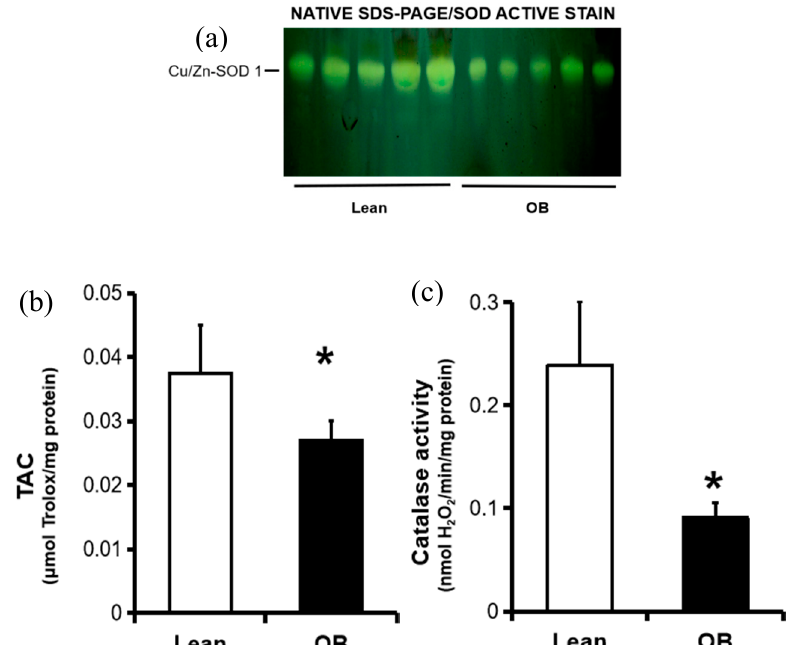
Figure 2. Endogenous antioxidant activity in full-term placentas from normal weight (lean, n = 9) and obese (OB, n = 8) pregnancies. ( a ) SOD activity pattern was obtained by native SDS-PAGE on 10% (w / v) polyacrylamide gels, and then stained by the photochemical nitroblue tetrazolium method. For each sample, 40 µ g of protein was loaded per lane. A representative picture of all analyses of the isoenzymatic SOD activity is shown. ( b ) Catalase activity and ( c ) TAC were quantified by spectrophotometric analysis, as described in the “Material and Methods” Section. Results were reported as mean ± SD of enzymatic activity. * p < 0.05 relative to the lean group. Cu / Zn SOD: Copper /